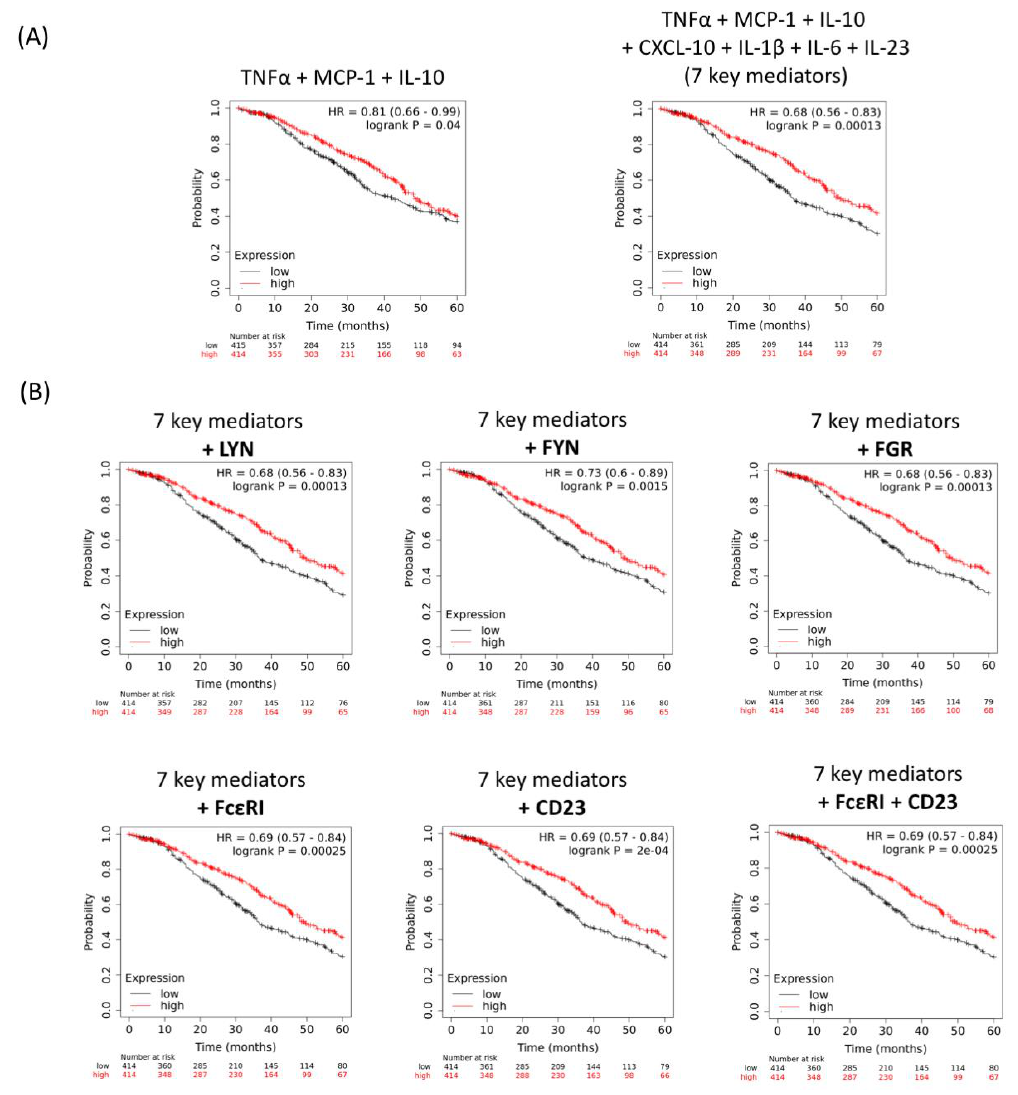
Figure 6. IgE-mediated cytokines, chemokines and protein kinase signatures may be associated with favourable patient survival in ovarian cancer. Kaplan–Meier survival curves showing high intratumoural gene expression (red) of immune mediator combinations, linked with IgE stimulation in our study, which is associated with improved five-year overall survival in 1656 ovarian cancer patients. ( A ) TNFα + MCP-1 + IL-10 and TNFα + MCP-1 + IL-10 + CXCL-10 + IL-1β + IL-6 + IL-23 (7